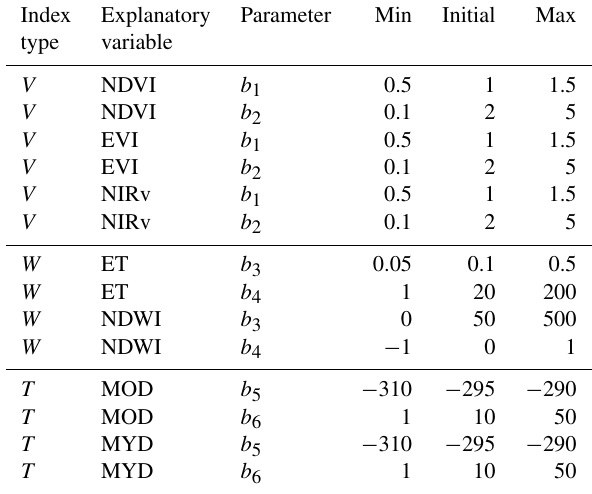
Table 1. Boundary conditions used to initialise the calibration pro- cedure for every local optimisation dependent on the explanatory variables used as a proxy for the vegetation V and for the water W and thermal T